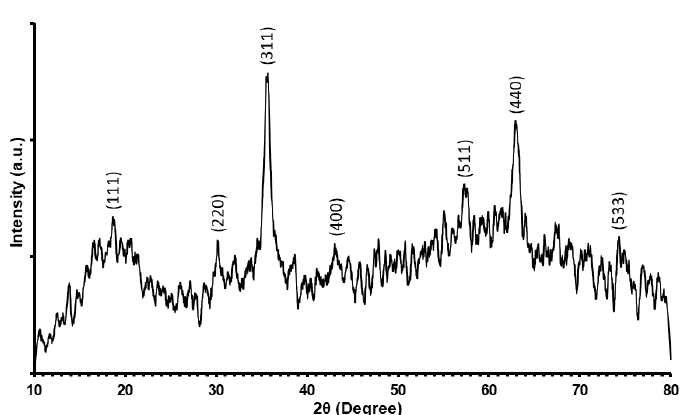
Figure 5. X-ray diffraction (XRD) pattern of synthesized Fe 3 O 4 nanoparticles.